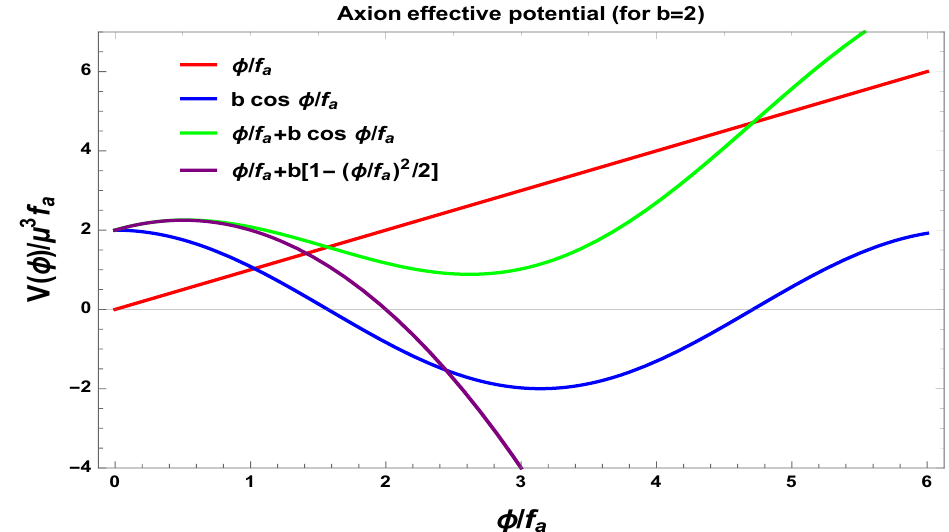
Figure 3. Behaviour of the axion effective potential obtained from Type IIB String Theory with respect to the dimensionless field value φ / f a , where f a is the axion decay